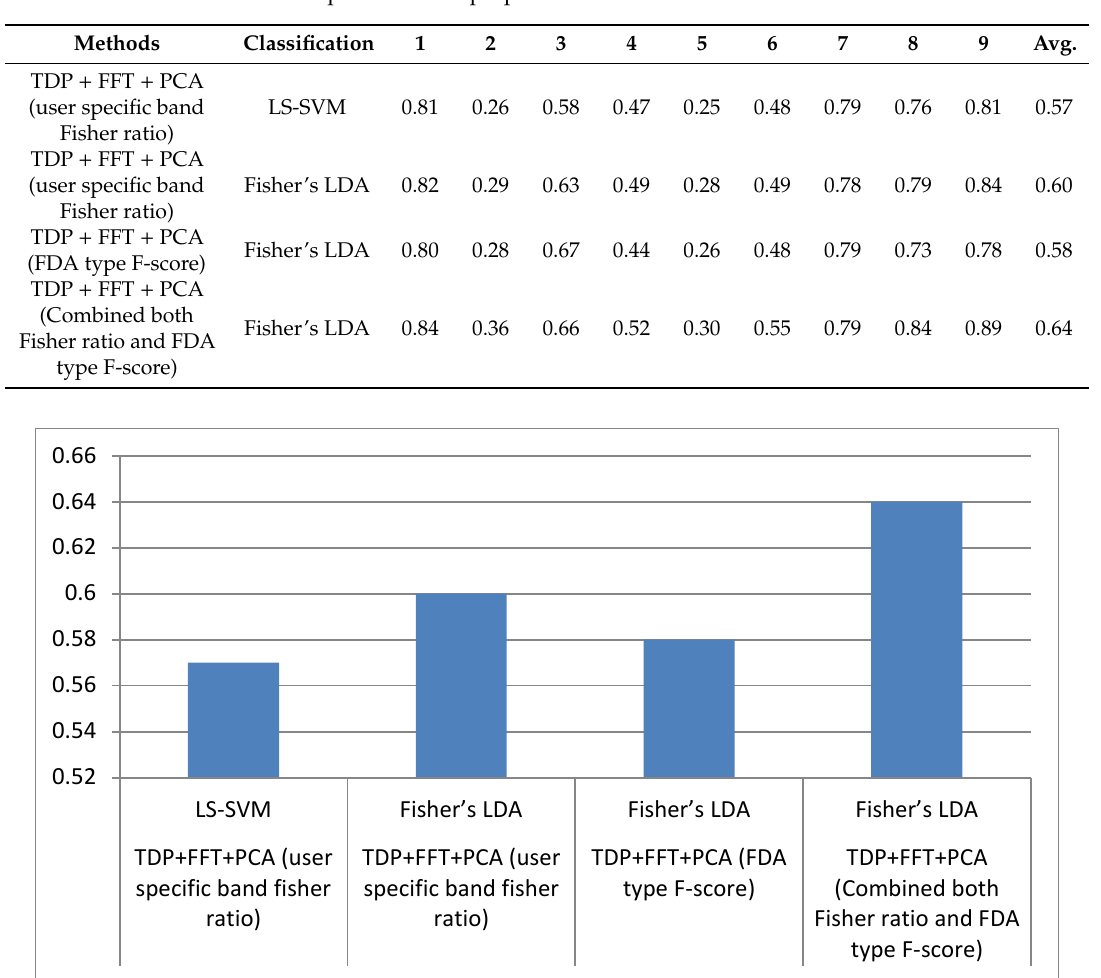
Table 4. Comparison of the proposed method with other combinations.